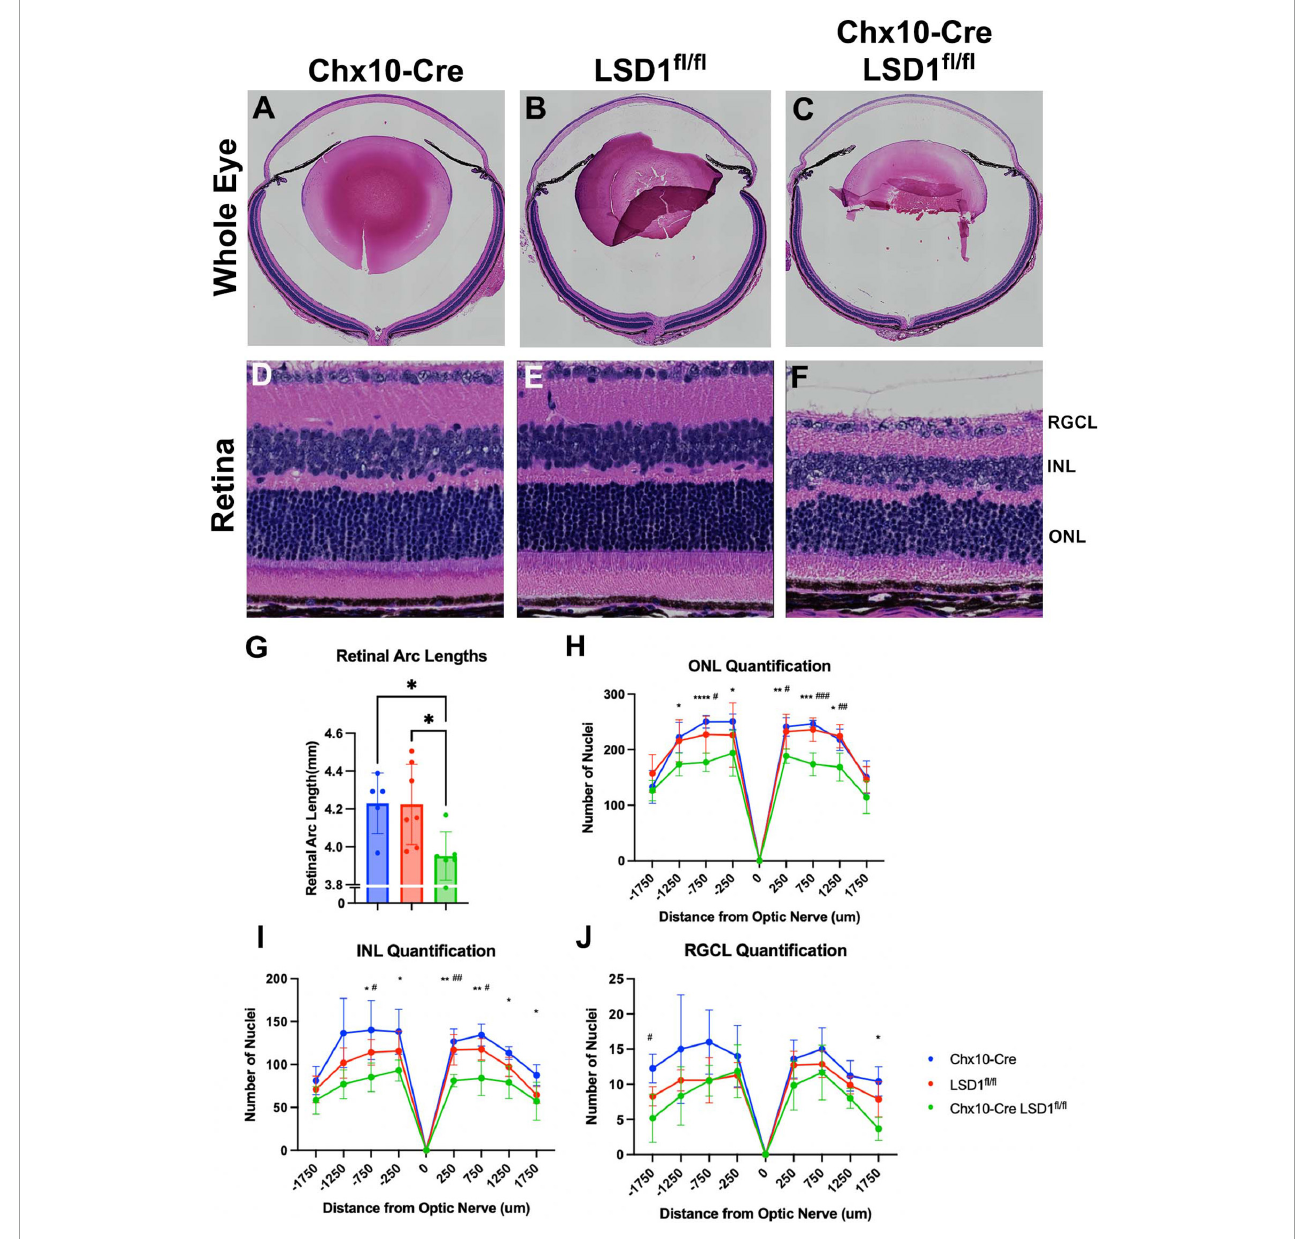
FIGURE4 Chx10-Cre Lsd1 fl / fl showed modest signs of retinal thinning and irregular morphology in Hematoxylin and Eosin (H&E) staining compared to controls; however, the laminar structure and organization was present. Whole eye images (A–C) and high magnification retina images (D–F) are shown for all three groups. Chx10-Cre Lsd1 fl / fl mice show significant total retinal thinning and disorganized ONL and INL (F) compared to both control groups in panels (D,E) . Quantification of total retinal arc length (G) show significant decrease in retinal arc length in Chx10-Cre Lsd1 fl / fl mice compared to control groups. Quantification of nuclei in the ONL (H) , INL (I) , and RGCL (J) show significant decreases in cell number in ONL and INL, but not RGCL, of Lsd1 fl / fl mice compared to both control groups. Quantification of total retinal arc length (J) show significant decrease in retinal arc length in Chx10-Cre Lsd1 fl / fl mice compared to control groups. One–Way ANOVA with Tukey’s multiple comparisons test for retinal lengths and Two–Way ANOVA with Tukey’s multiple comparisons test for ONL, INL, and RGCL cell nuclei quantification * , # p -value < 0.05; ** , ## p -value < 0.01; *** , ### p -value < 0.001; **** p -value < 0.0001. *Symbols indicate significance between Chx10-Cre controls and Chx10-Cre Lsd1 fl / fl ; # symbols indicate significant between Lsd1 fl / fl controls and Chx10-Cre Lsd1 fl / fl . Samples sizes: Chx10-Cre ( n = 5), Lsd1 fl / fl ( n = 7), Chx10-Cre Lsd1 fl / fl ( n = 6). Full list of statistical results can be found in Supplementary Tables 7 – 10